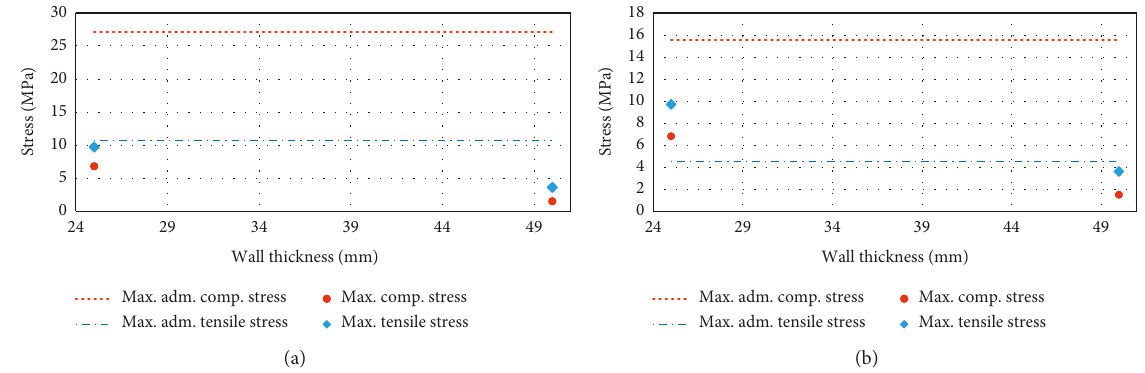
Figure 13: Comparison between maximum tensile and compressive stresses and maximum admissible tensile and compressive stresses for (a) Utility Structure 1 and (b) Utility Structure 2 as a function of the wall thickness.